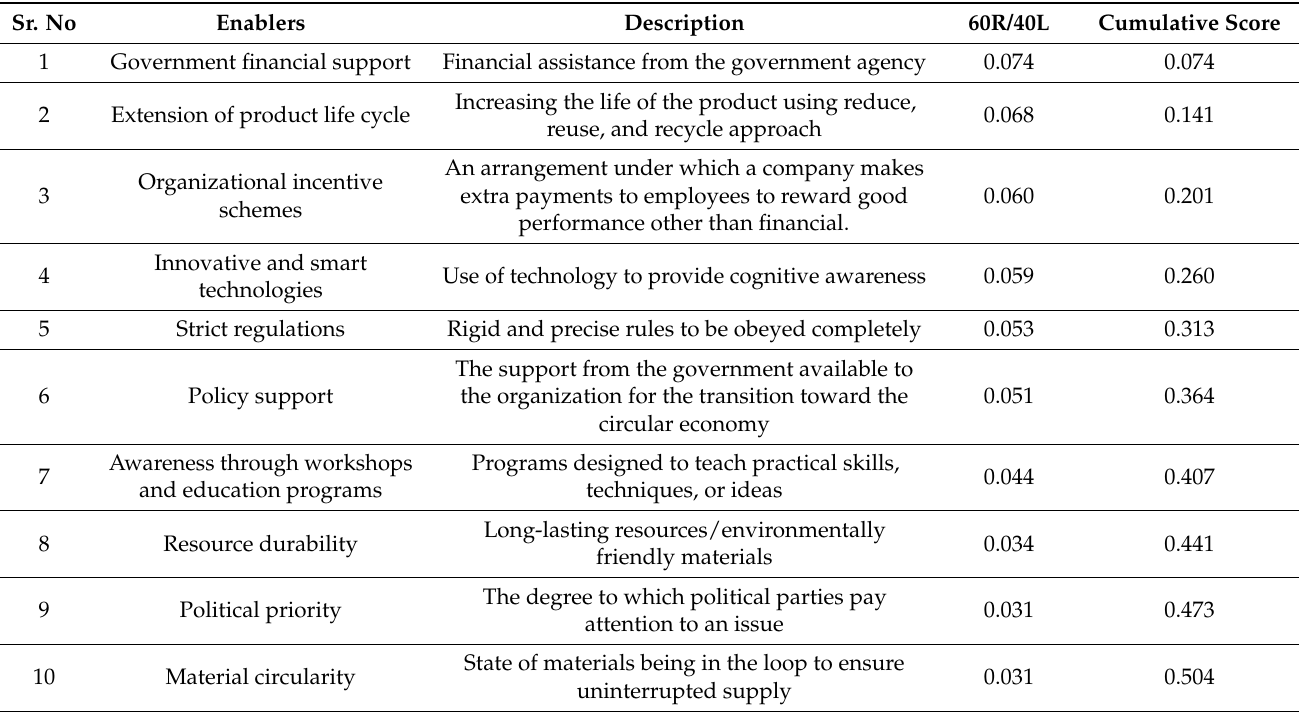
Table 3. Shortlisted